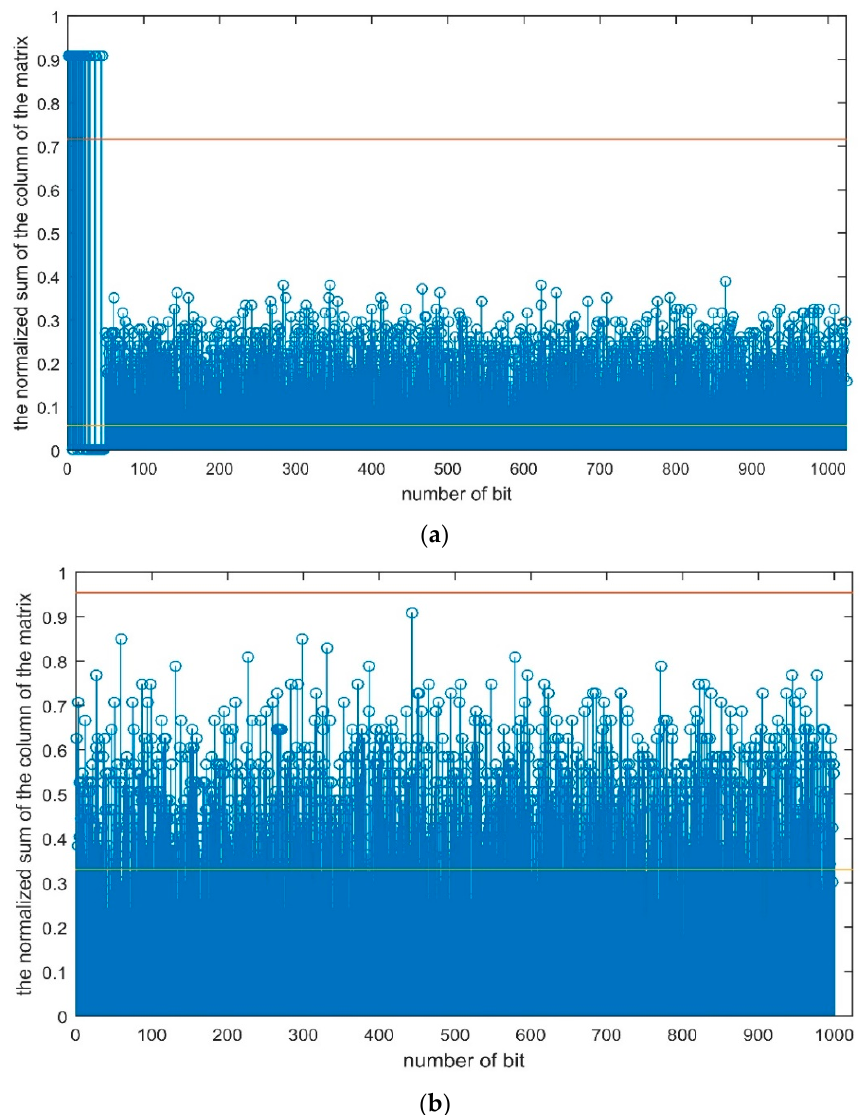
Figure 4. This is the result of Y ∗ sum when BER is 0. ( a ) The peak appears when the frame estimation is right. ( b ) No peak appears when the frame estimation is fault.